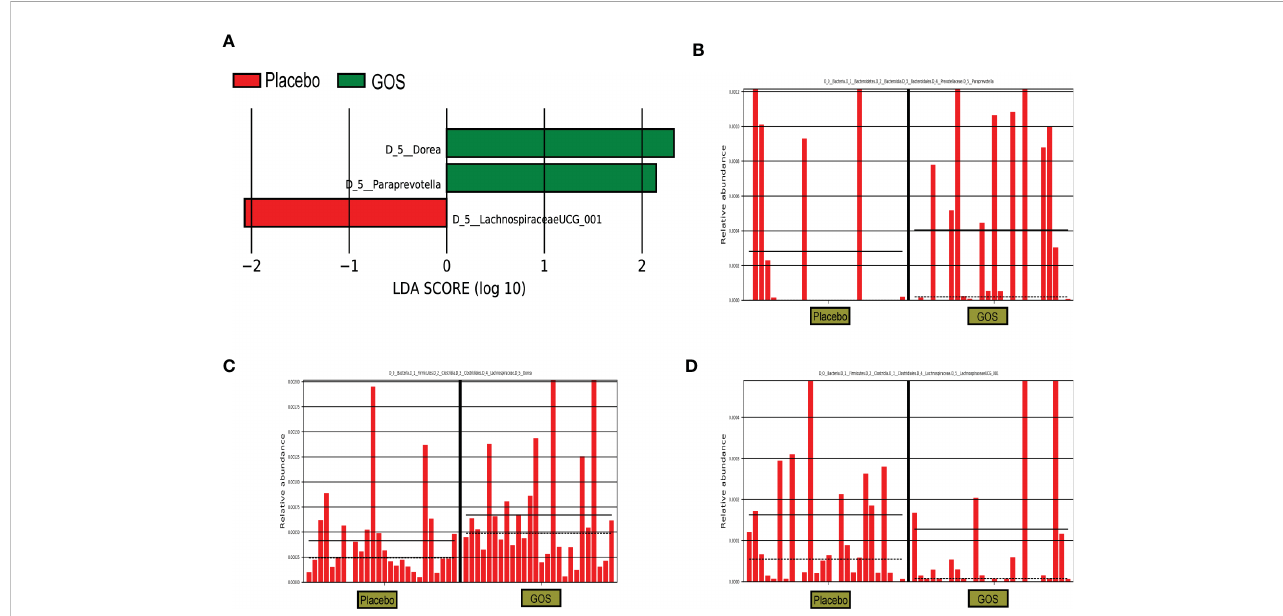
FIGURE 4 Identi fi cation of the most differentially abundant analyzed by the LEfSe method. (A) LDA scores of differentially abundant taxa. (B) Relative abundance of Paraprevotella. (C) Relative abundance of Dorea. (D) Relative abundance of LachnospiraceaeUCG_001.